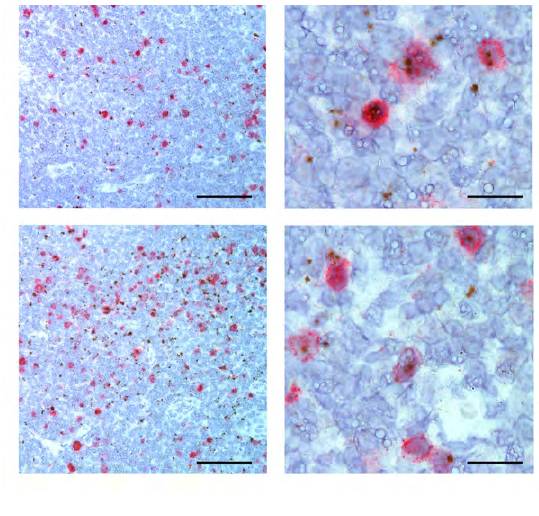
Figure 6. Duplex Viral RNA and vDNA detection in the same tissue section. Representative low (left panel; scale bar = 200 µm) and high magnification (right panel; scale bar = 50 µm) images demonstrating the combination of both RNAscope and DNAscope in a chronically SIV-infected RM lymph node demon- strating the ability to detect vRNA and vDNA in the same tissue section and providing a powerful ap- proach to identify transcriptionally silent vDNA+ vRNA- cells in situ